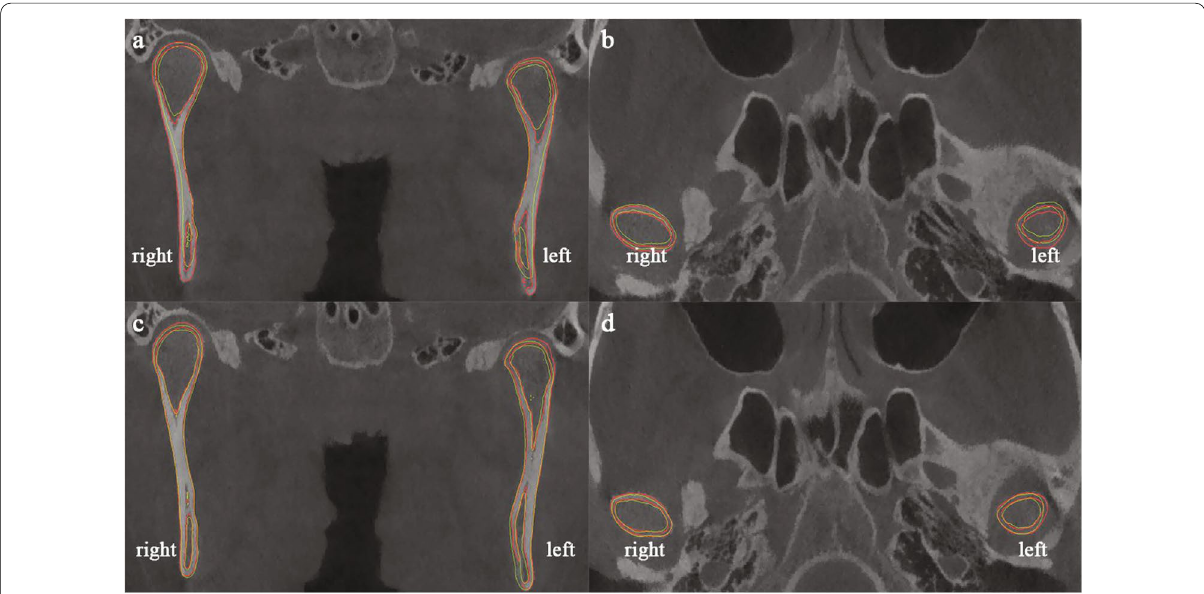
Fig.4 The deviated side of the mandible is on the patient’s own left side. The red image represents T2 and the yellow image represents T1. a , b : cranial base registration; c , d : mandibular